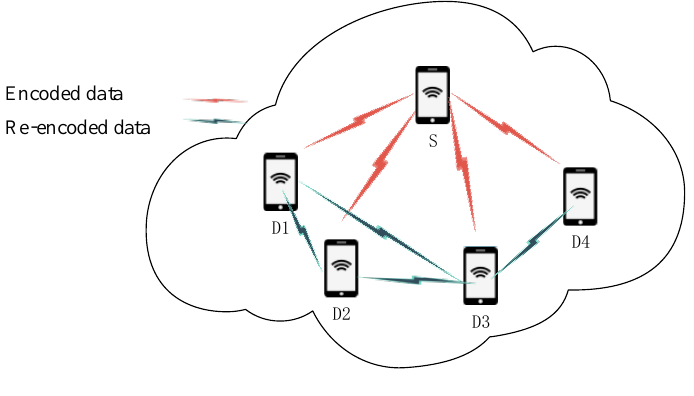
Figure 1. Network Figure 1. Network model.